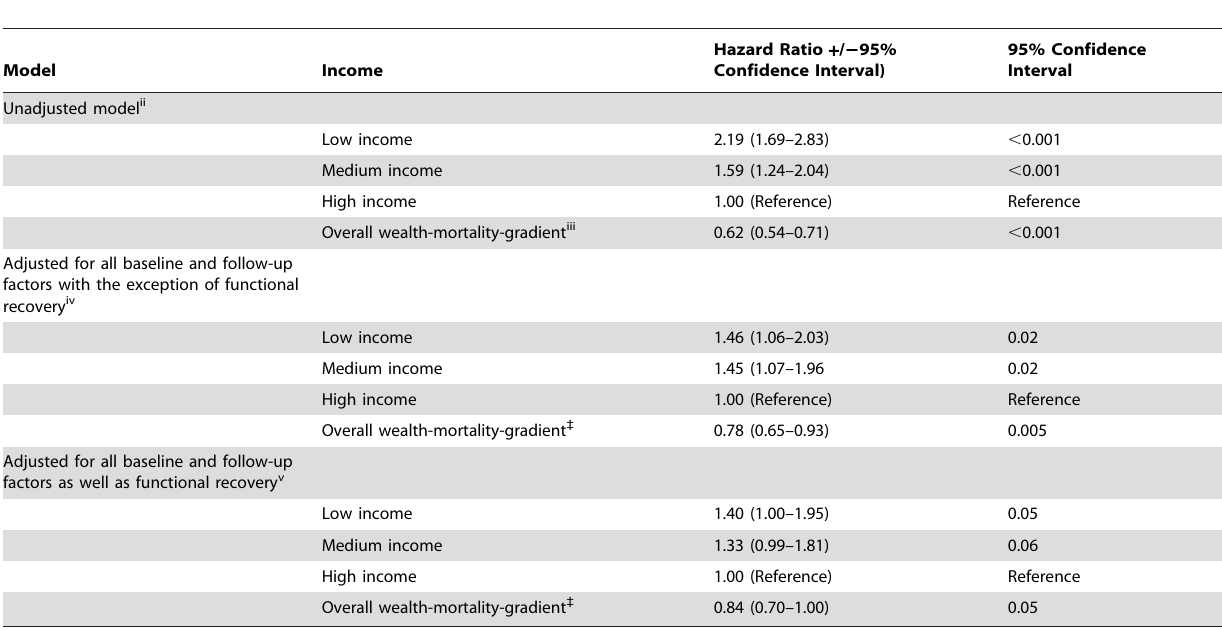
Table 4. The relationship between income and long-term survival after sequential adjustments for factors associated with one- year recovery i